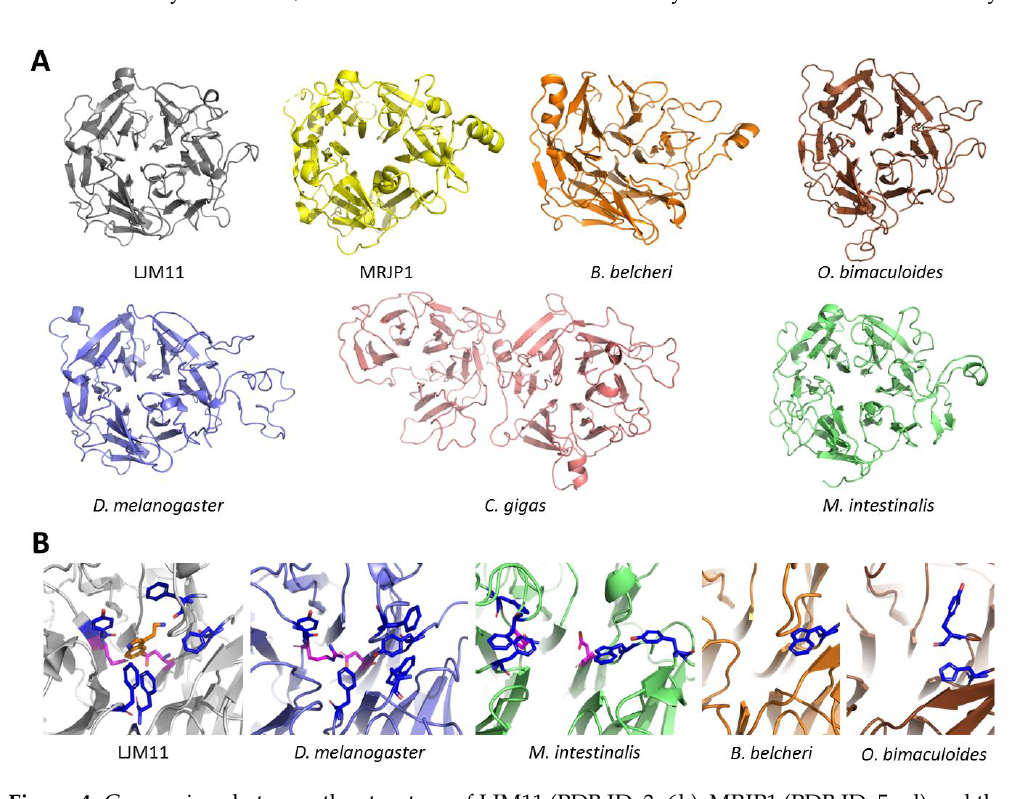
between the two MRJP domains, representing the one with the highest identity with A. mellifera MRJP1,